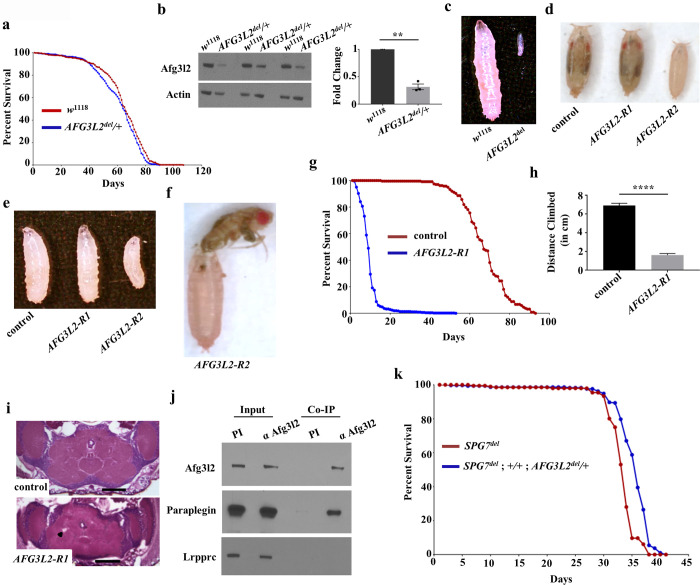
AFG3L2 null mutants die early in development, but neuron-specific inactivation of AFG3L2 confers shortened adult lifespan, locomotor defects, and neurodegeneration.a. Kaplan–Meier survival curves of control (w1118; N = 480, 50% survival 66 days) and AFG3L2 heterozygotes (AFG3L2del/+; N = 548, 50% survival 65 days). b. Western blot analysis of protein homogenates from 1-day old controls (w1118) and AFG3L2 heterozygotes (AFG3L2del/+) using antisera against Afg3l2 and actin. Afg3l2 band intensity was normalized against actin (n = 3 independent biological replicates, **p < 0.01 by Student’s t-test). c. Size comparison of control (w1118) and AFG3L2 null homozygous larvae (AFG3L2del/del) 4 days after egg hatching. d, e. Size comparison of control animals (UAS-LUCIFERASE RNAi/da-Gal4) and flies expressing RNAi lines targeting AFG3L2 in a ubiquitous manner (UAS-AFG3L2-R1 RNAi; da-Gal4 or UAS-AFG3L2-R2 RNAi/da-Gal4). Images show pupae 9 days after egg hatching (d) and larvae 4 days after egg hatching (e). f. Pan-neuronal expression of the strong RNAi line targeting AFG3L2 (elav-Gal4; +/+; UAS-AFG3L2-R2 RNAi) resulted in the failure of flies to eclose from the pupal case. g. Kaplan–Meier survival curves of flies expressing the control LUCIFERASE RNAi (elav-Gal4; +/+; UAS-LUCIFERASE RNAi; N = 238, 50% survival 67 days) and weak RNAi line targeting AFG3L2 (elav-Gal4; UAS-AFG3L2-R1 RNAi; N = 465, 50% survival 9 days) throughout the nervous system. Significance was determined using a Mantel-Cox log-rank test (****p < 0.0001). h. Climbing performance of 1-day old adult flies expressing the control LUCIFERASE RNAi (elav-Gal4; +/+; UAS-LUCIFERASE RNAi; N = 70) and the weak RNAi line targeting AFG3L2 (elav-Gal4; UAS-AFG3L2-R1 RNAi; N = 75) throughout the nervous system (****p < 0.0005 by Student’s t-test). i. Hematoxylin and eosin staining of paraffin-embedded head sections from 1-day old controls (elav-Gal4; +/+; UAS-LUCIFERASE RNAi) and flies expressing the weak RNAi line targeting AFG3L2 (elav-Gal4; UAS-AFG3L2-R1 RNAi) throughout the nervous system. The black arrowhead indicates a vacuole. The scale bar is 100 μm. j. Western blot analysis of Drosophila proteins immunoprecipitated using an antiserum against Afg3l2 (α Afg3l2). A pre-immune serum (PI) was used as a negative control. The blot was incubated with antiserum against Afg3l2 to confirm successful immunoprecipitation of Afg3l2, and an antiserum against Paraplegin to test for co-immunoprecipitation of Paraplegin. An antiserum against Leucine-Rich Pentatricopeptide Repeat Containing (LRPPRC) protein was used as a negative control. k. Kaplan–Meier survival curves of SPG7 null mutants (SPG7del; N = 196, 50% survival 34 days) and SPG7 null mutants that also bear a null allele of AFG3L2 (SPG7del; +/+; AFG3L2del/+; N = 291, 50% survival 36 days).